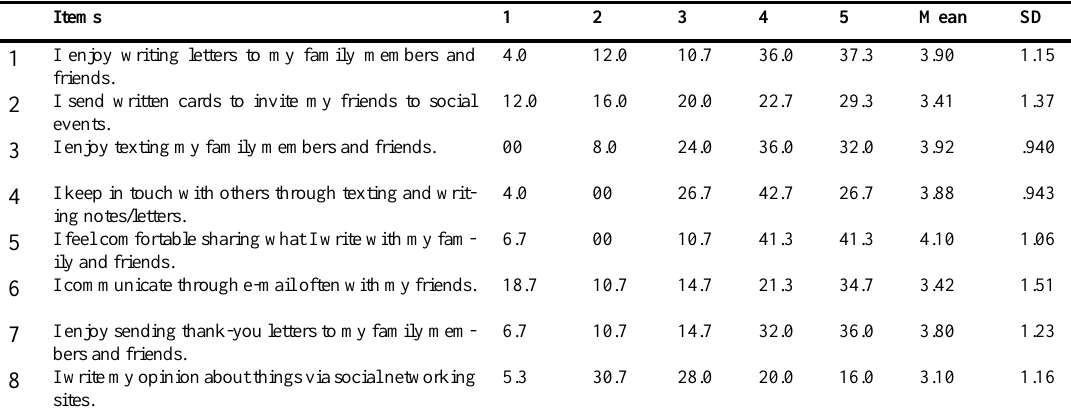
Table 3. Attitudes towards Social Purposes of Writing in English